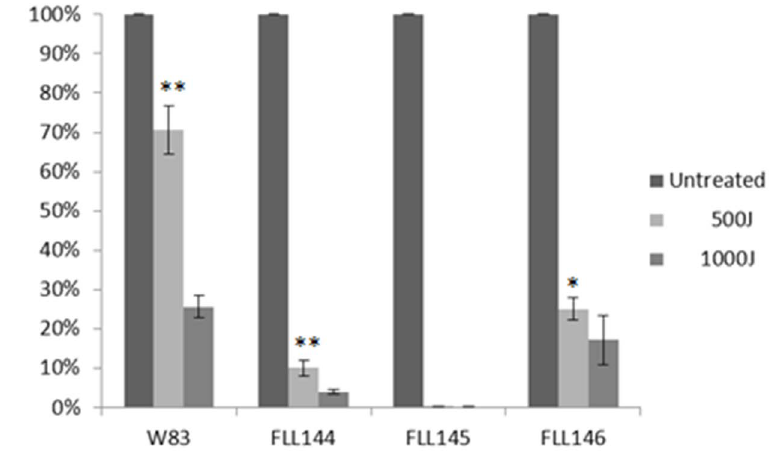
Figure 5. UV sensitivity of P.gingivalis mutants. P. gingivalis strains W83, FLL144, FLL145 and FLL146 were grown to mid log phase (OD 600 of 0.6) spread on BHI plates then subjected to irradiation at increasing doses (0 m J, 500 m J and 1000 m J) of UV in a Stratalinker 2400 (Stratagene, La Jolla, CA). **P # 0.01, *P # 0.05.